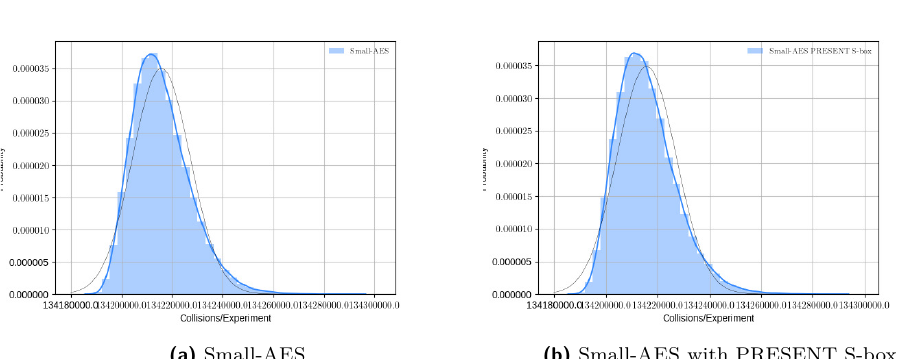
Figure 13: Distribution of the number of collisions in the first byte after five rounds taking all (cid:0) 2 16 (cid:1) pairs from a single plaintext diagonal. All distributions used 100 000 random keys and 2 counted the collisions for one diagonal per key. Thin lines are fitted normal distributions, thick lines the best fitted